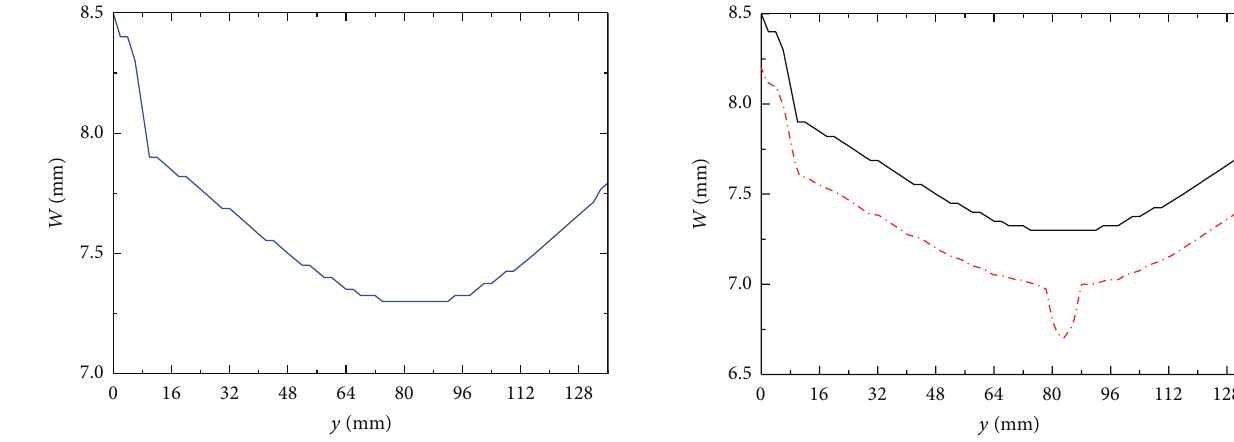
Figure 6: Variation of the width 𝑊 along 𝑦 -axis.